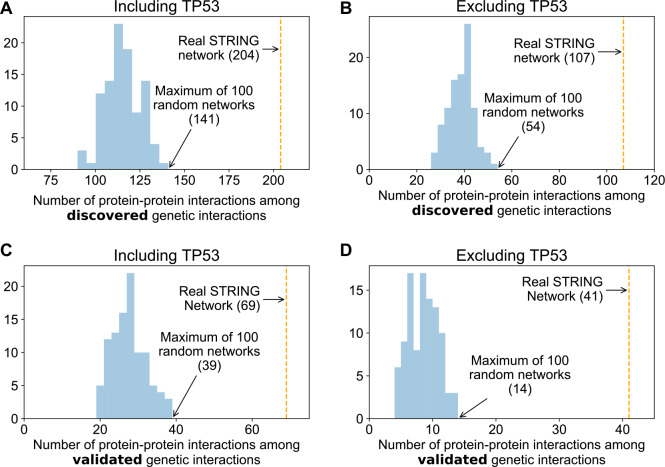
Genetic interactions are more enriched in real protein–protein interaction networks than randomised networks.Histograms showing the overlap between 100 degree matched randomisations of the STRING medium confidence protein–protein interaction and discovered (A and B) and validated (C and D) genetic interactions. The observed overlap with the real STRING protein interaction are highlighted with the orange lines.